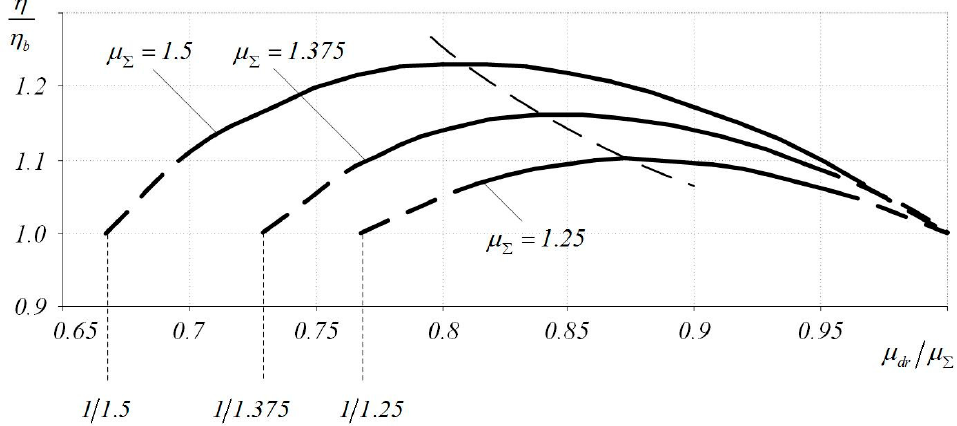
Figure 11. Curves of rolling process efficiency factored on the load of the idle rolls.